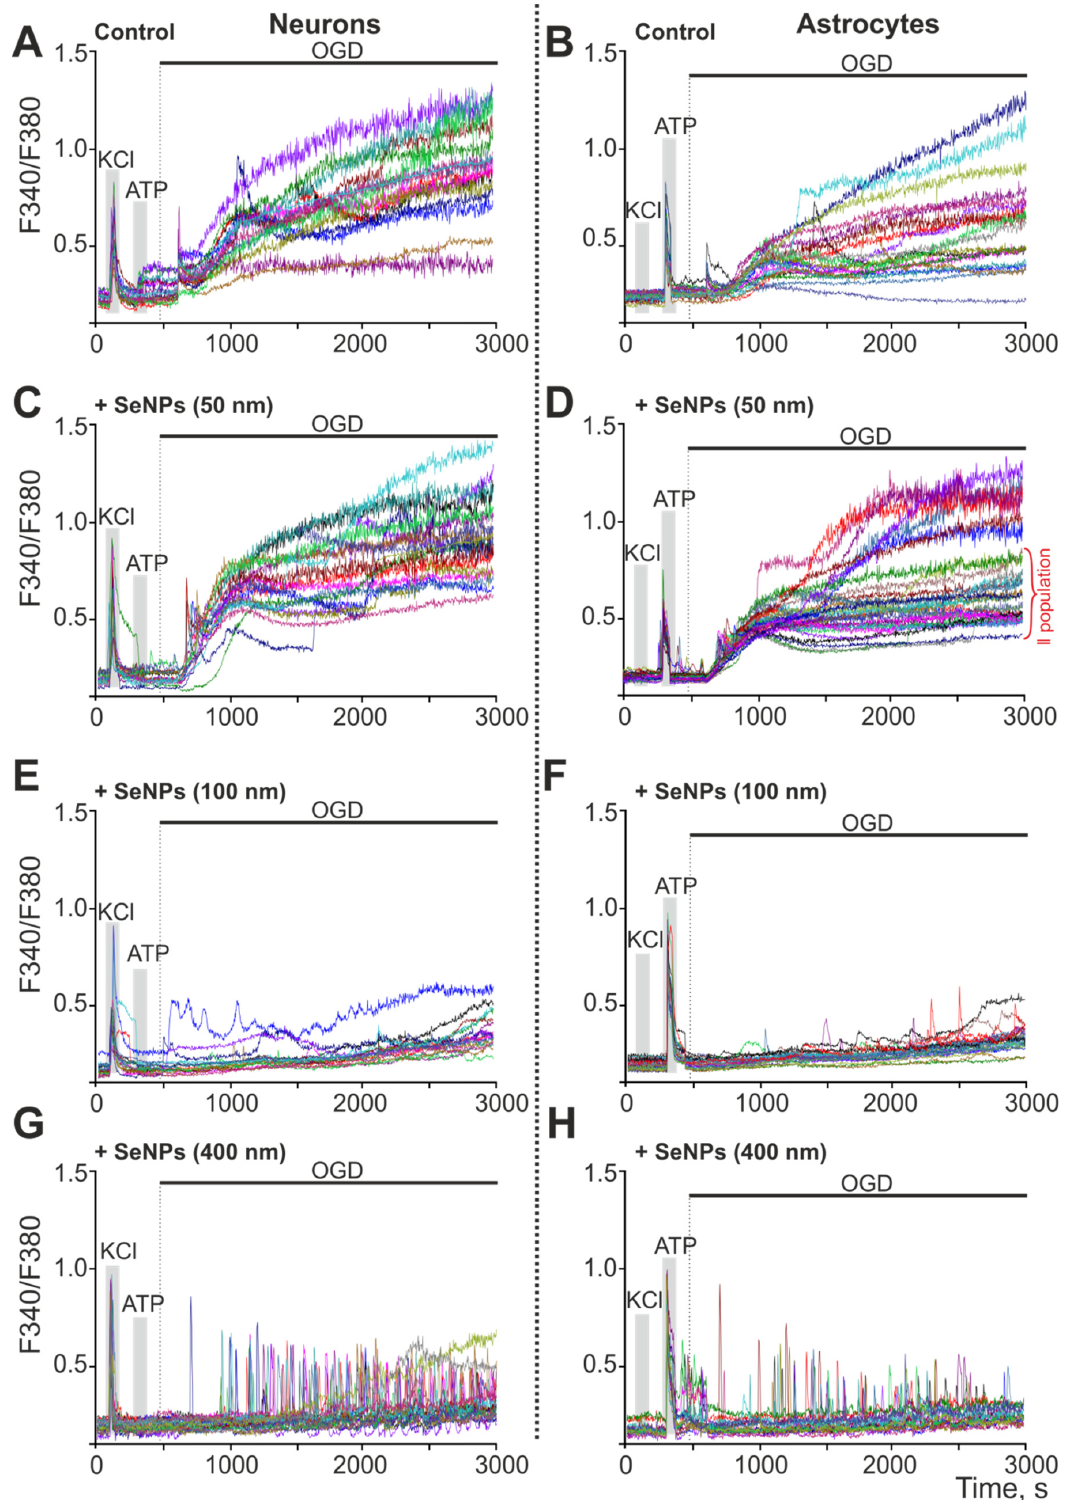
Figure 7. Ca 2+ signals of neurons and astrocytes on OGD (40 min) in control ( A , B ) and after 24-h pre-incubation with SeNPs 50 nm in diameter ( C , D ), 100 nm-sized ( E , F ), and 400 nm-sized ( G , H ). Short-term applications of 35 mM of KCl and 10 μ m of ATP were used to detect neurons and astrocytes, respectively. Cellular Ca 2+ signals in one experiment are shown. The experiments were performed in three repetitions on three separate cell cultures.